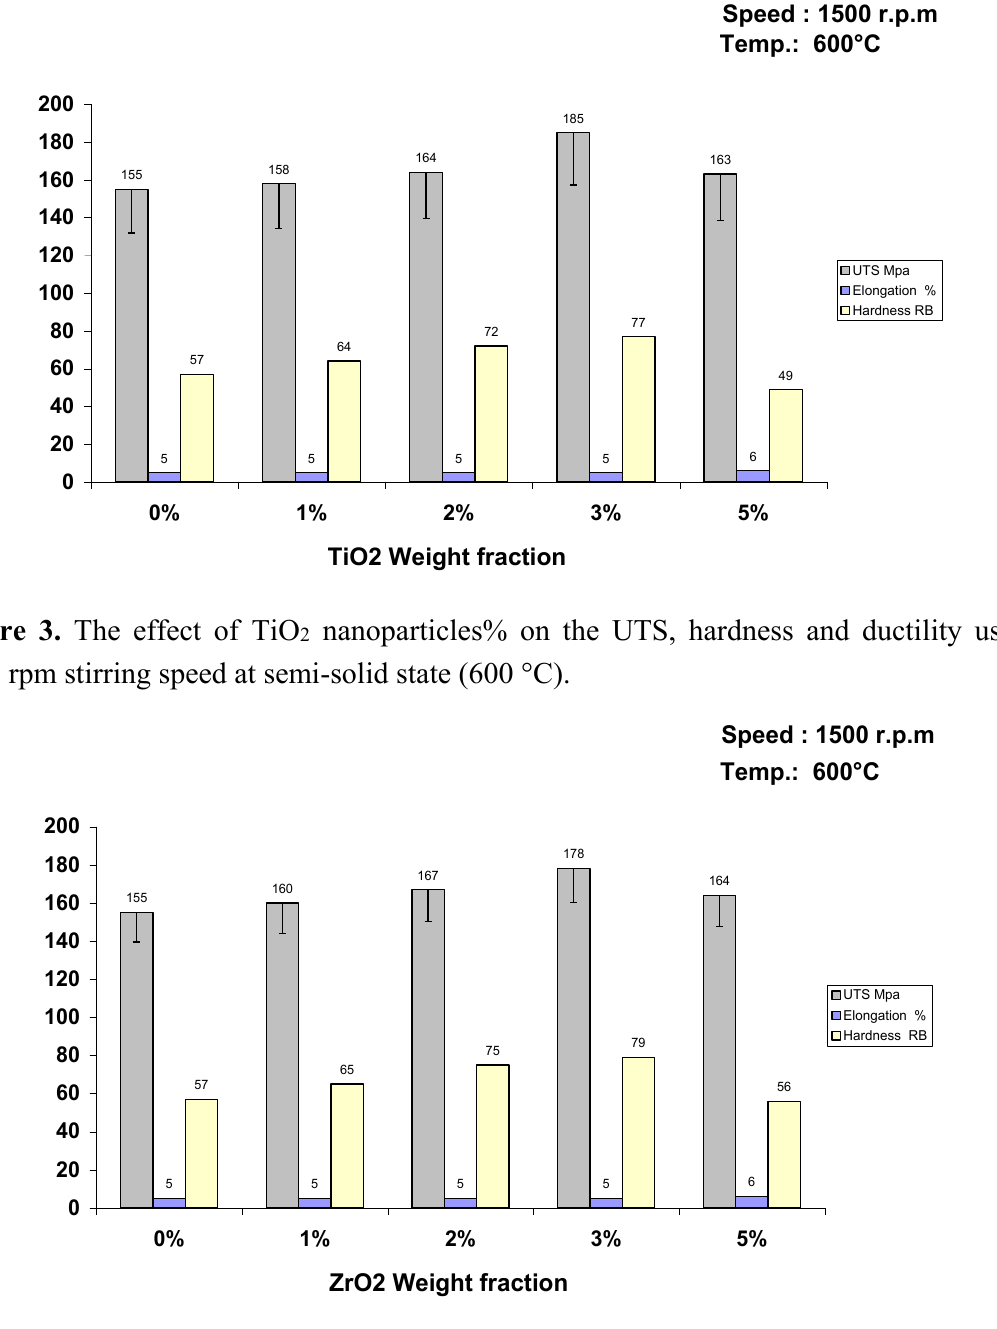
Figure 4. The effect of ZrO 2 nanoparticles% on the UTS, hardness and ductility using 1500 rpm stirring speed at semi-solid state (600